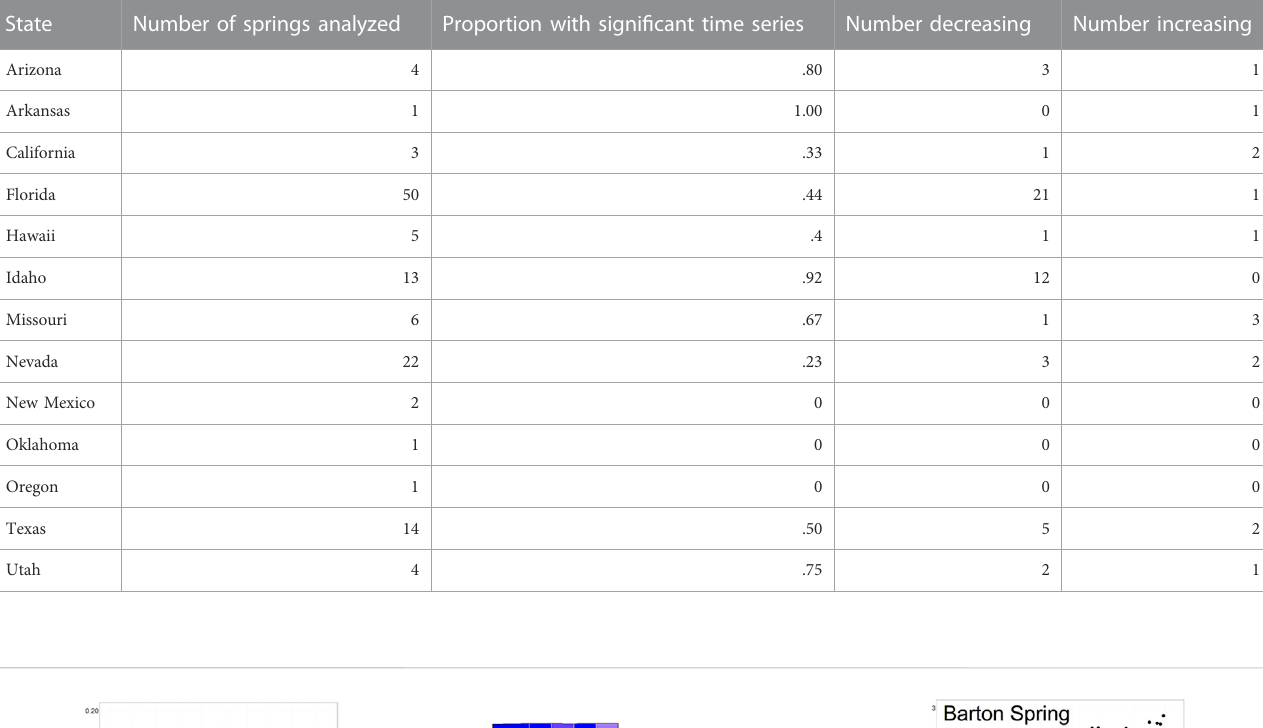
TABLE 1 Numbers of springs that were analyzed in each state, including the number of springs that showed signi fi cant increasing and decreasing trends.